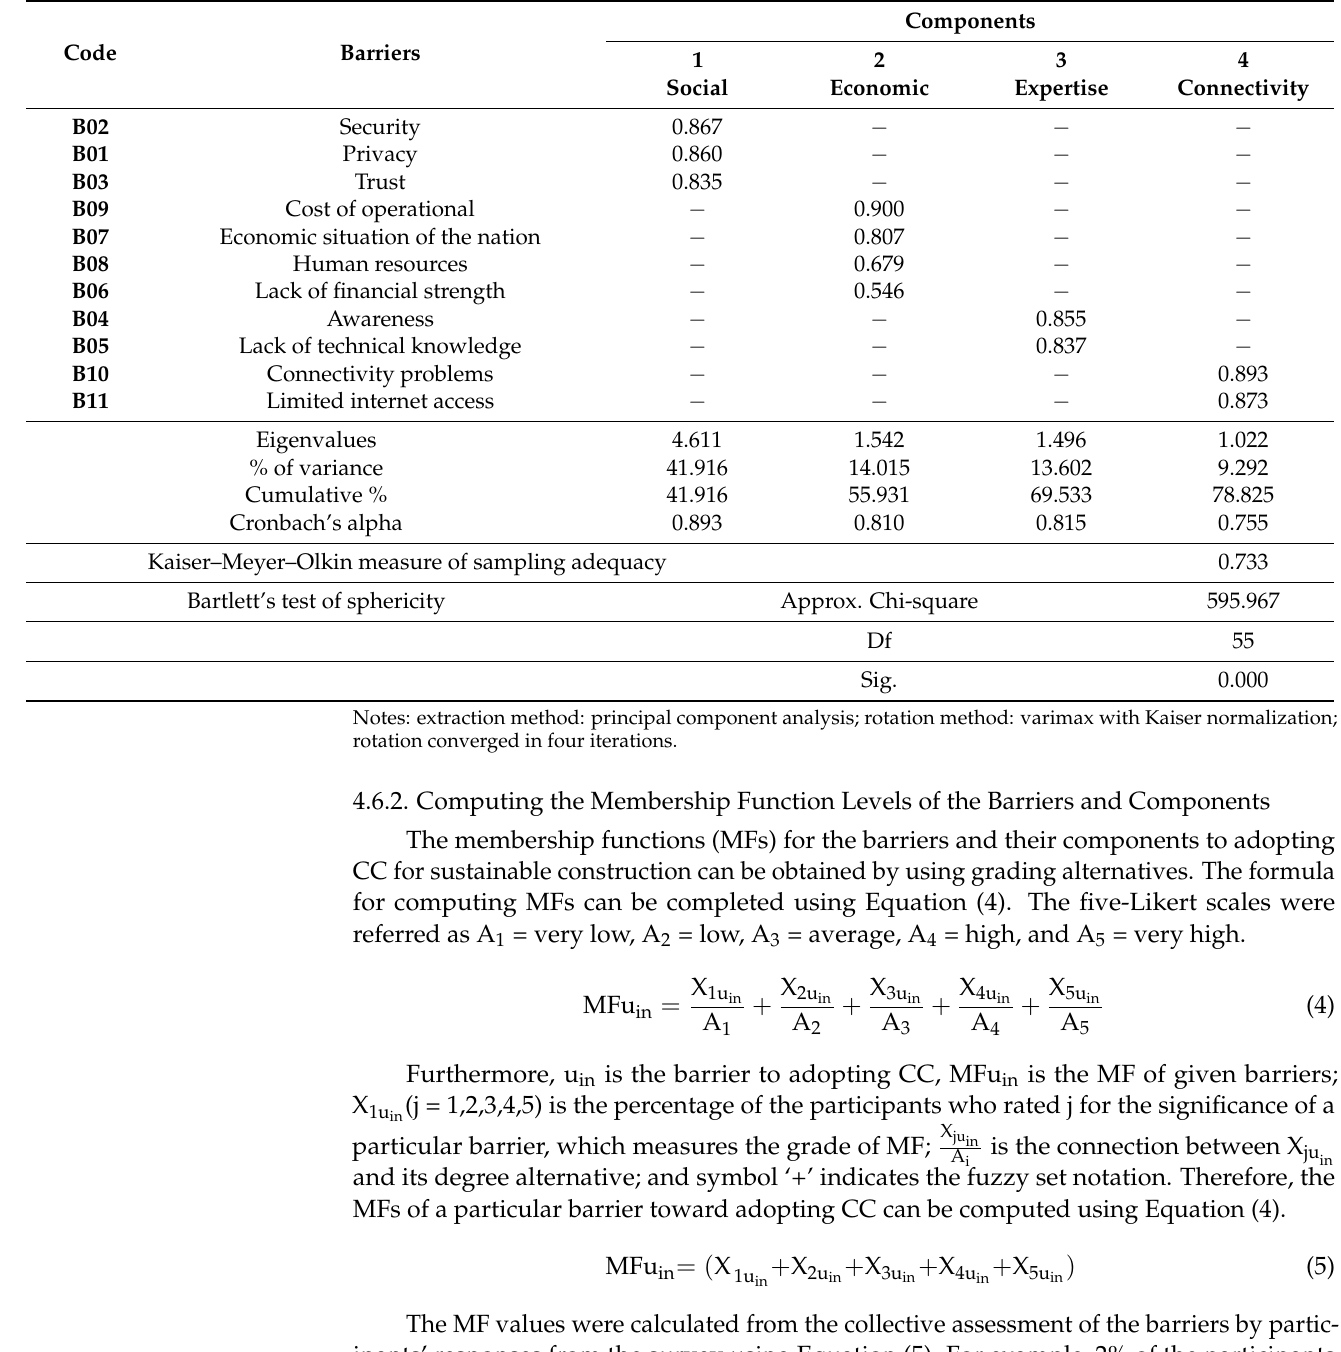
Table 5. Results for the summary of